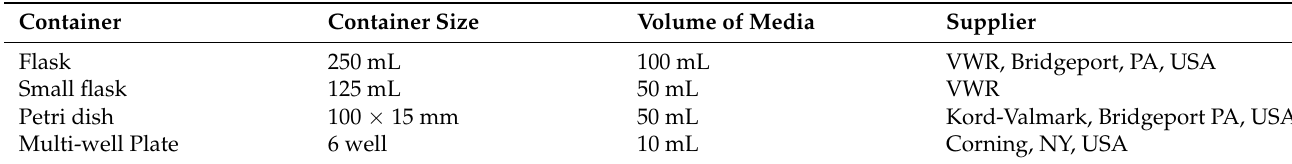
Media compositions. Table S2: Summary of Spirodela screens and experiments. Table S3: Screening for optimal flowering of W. microscopica 2005. Table S4: Summary of W. microscopica flowering rates in different containers and media, with and without EDDHA. Document S1: E medium